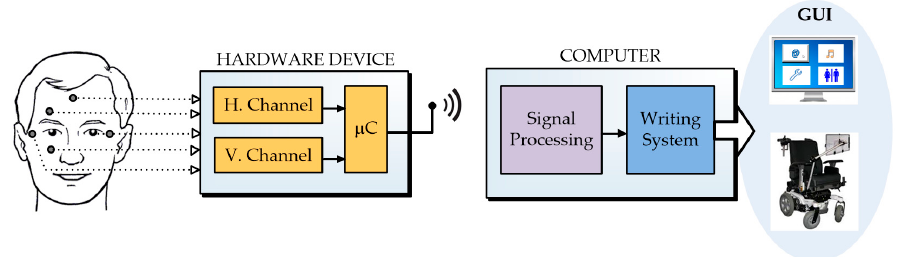
Figure 1. General view of the proposed system based on eye movements.